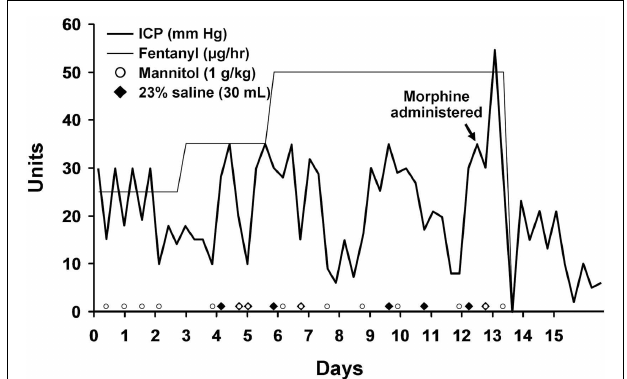
FIGURE 3 | Intracranial pressure is plotted over time. The timing of morphine and fentanyl administration are shown. Rescue doses of hyperosmolar therapy are plotted at the bottom of the